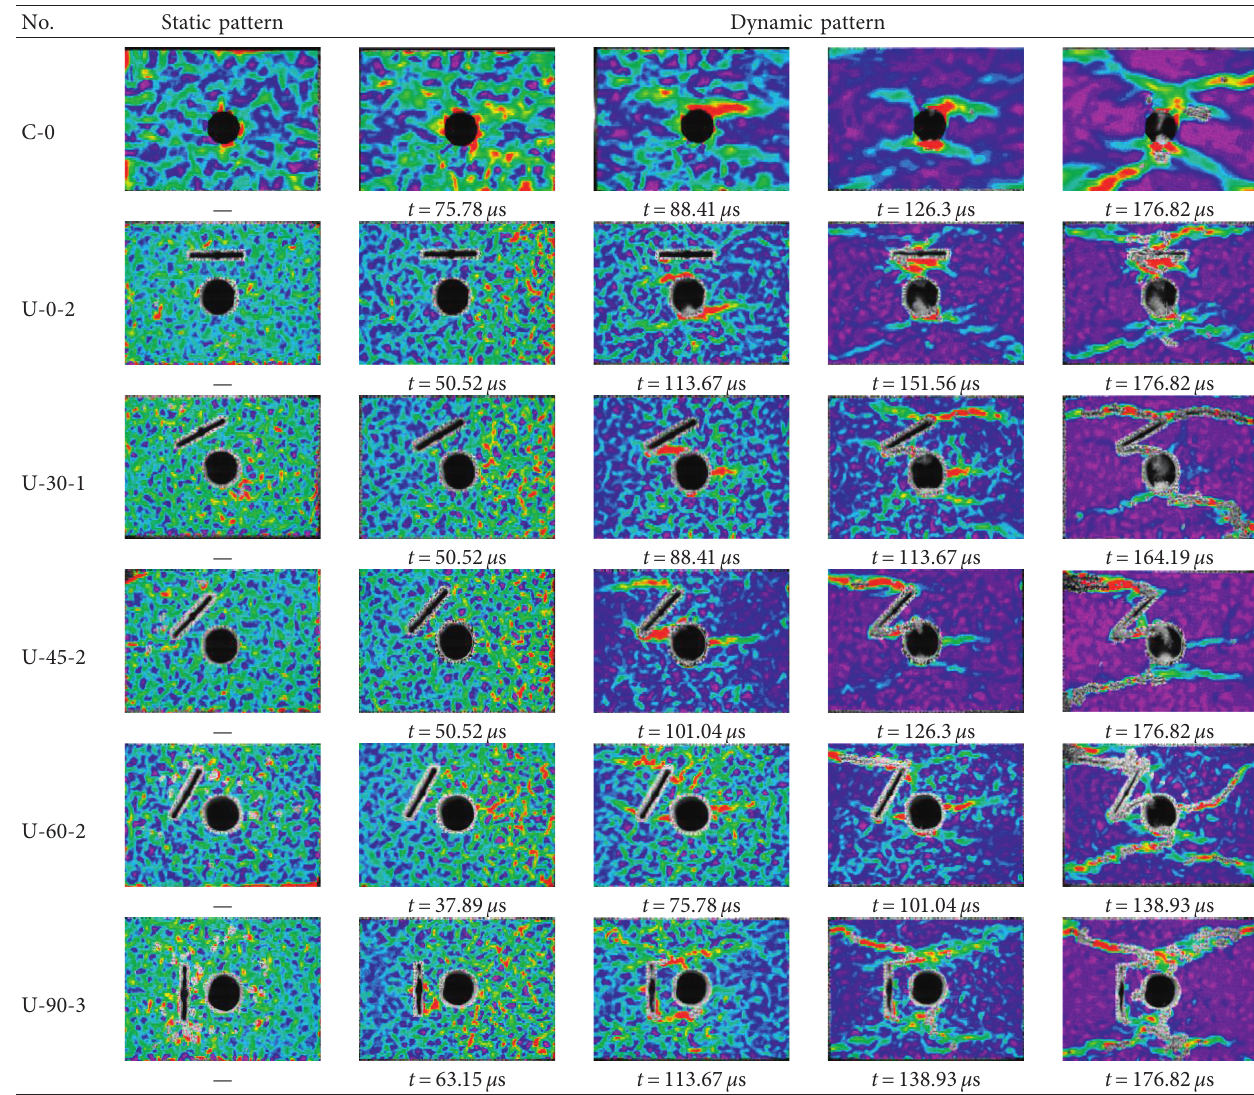
Table 4: The major principal strain contours of typical specimens during the